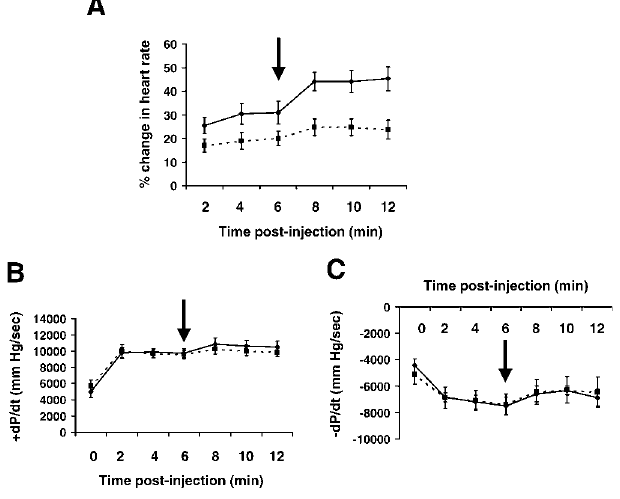
Figure 8. PGC1 b KO Hearts Display a Blunted Heart Rate Response to Dobutamine Stimulation In Vivo PGC1 b KO and WT littermates (male, 26-wk-old) were treated as stated in Material and Methods and infused with 10 or 40 ng/min/g BW dobutamine to measure in vivo hemodynamic responses WT, solid line; KO, dashed line. (A) Percentage change in heart rate from basal during dobutamine infusion. (B and C) Measurement of ventricular performance, dP / dt , during infusion. The arrow marks the increase in dobutamine concentration in the infusion from 10 to 40 ng/min/g BW. n ¼ 5 mice per genotype. DOI: 10.1371/journal.pbio.0040369.g008